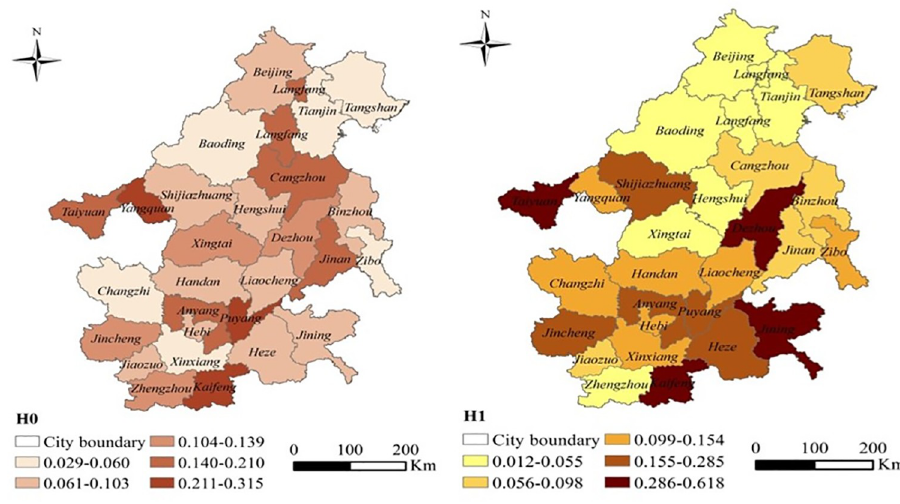
Fig 3. Pollutant emission agglomeration in the BTH “2+26” cities. The map was prepared in ARCGIS using political boundaries from the Global Database of Administrative Areas (https://resources.arcgis.com/en/help/).